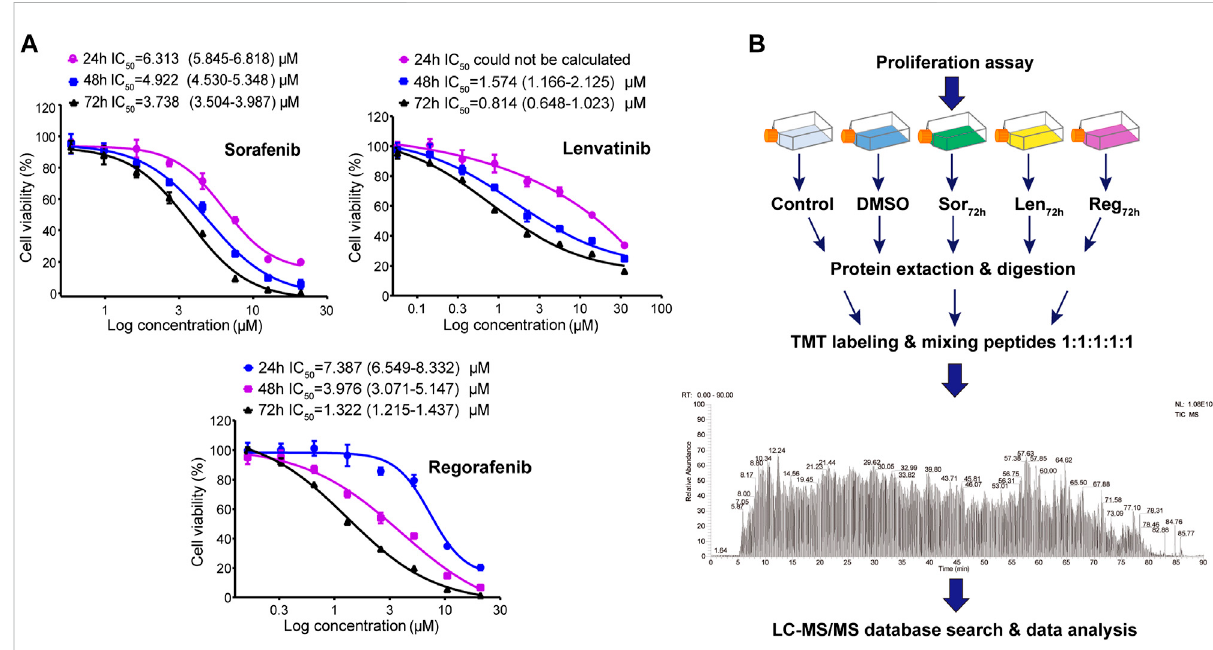
FIGURE 1 Dose-responsecurves of thecellgrowth inhibition bysorafenib-, lenvatinib-and regorafenib-incubation (24,48 and72 h)inHuh-7cells; each point presents mean ± SD, n = 6 per concentration (A) ; and work fl ow of TMT-based proteomic experiments (B) . See Methods for experimental